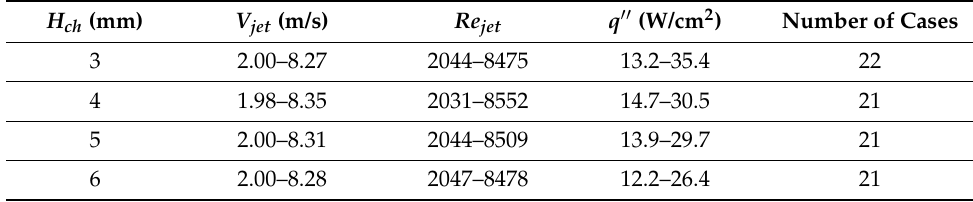
Table 2. Experimental operating